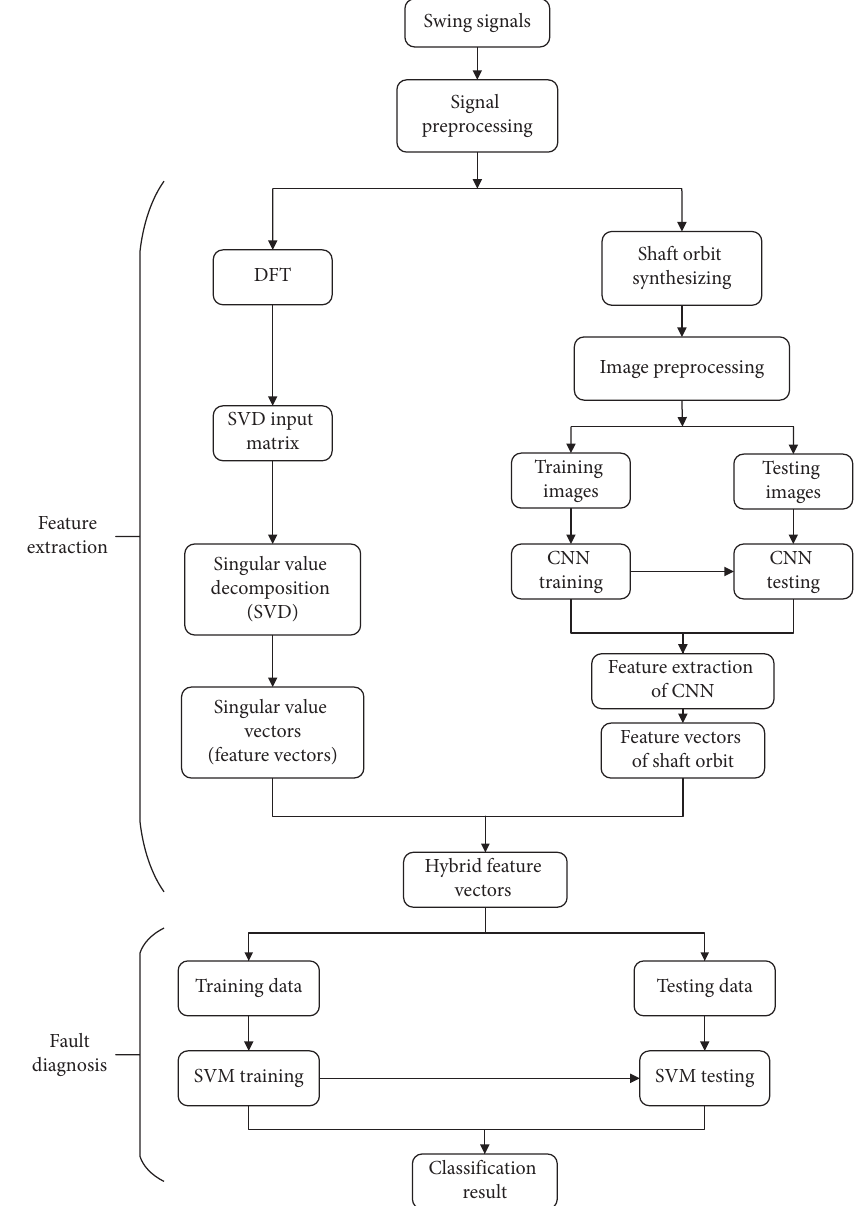
Figure 2: Flowchart of the hybrid fault diagnosis